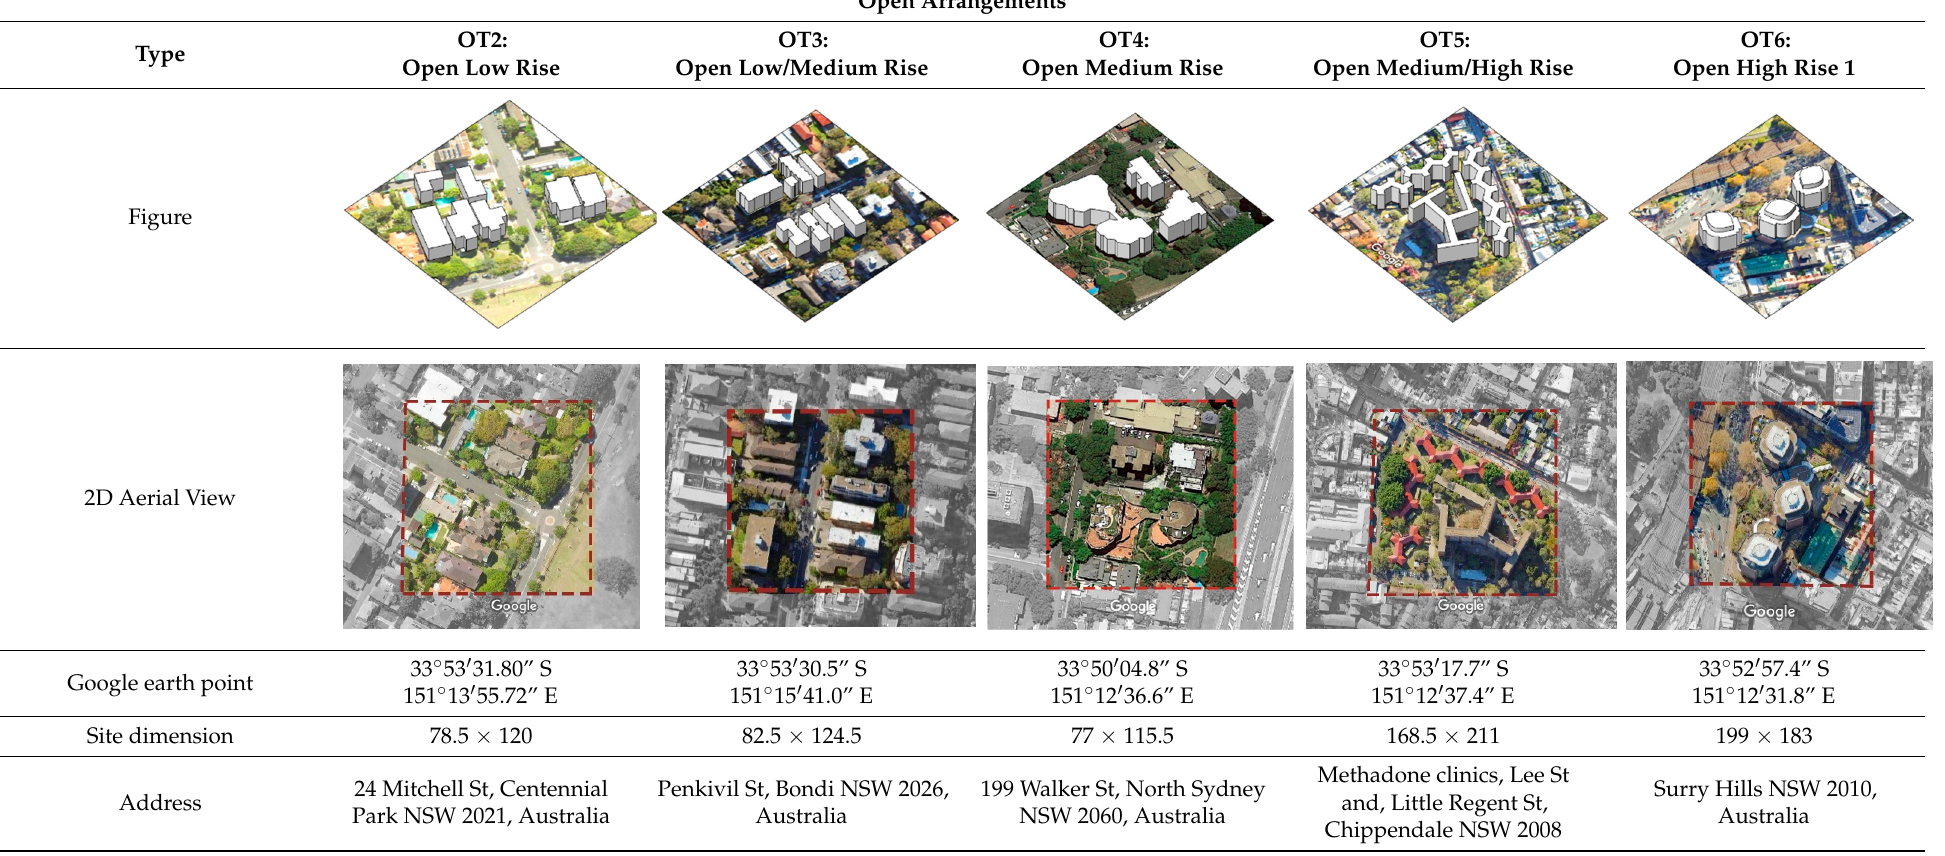
Table 3. Open Arrangement classifications in urban configurations with their corresponding 2D, 3D view, site dimension, and locations in the city of Sydney. Open Arrangements